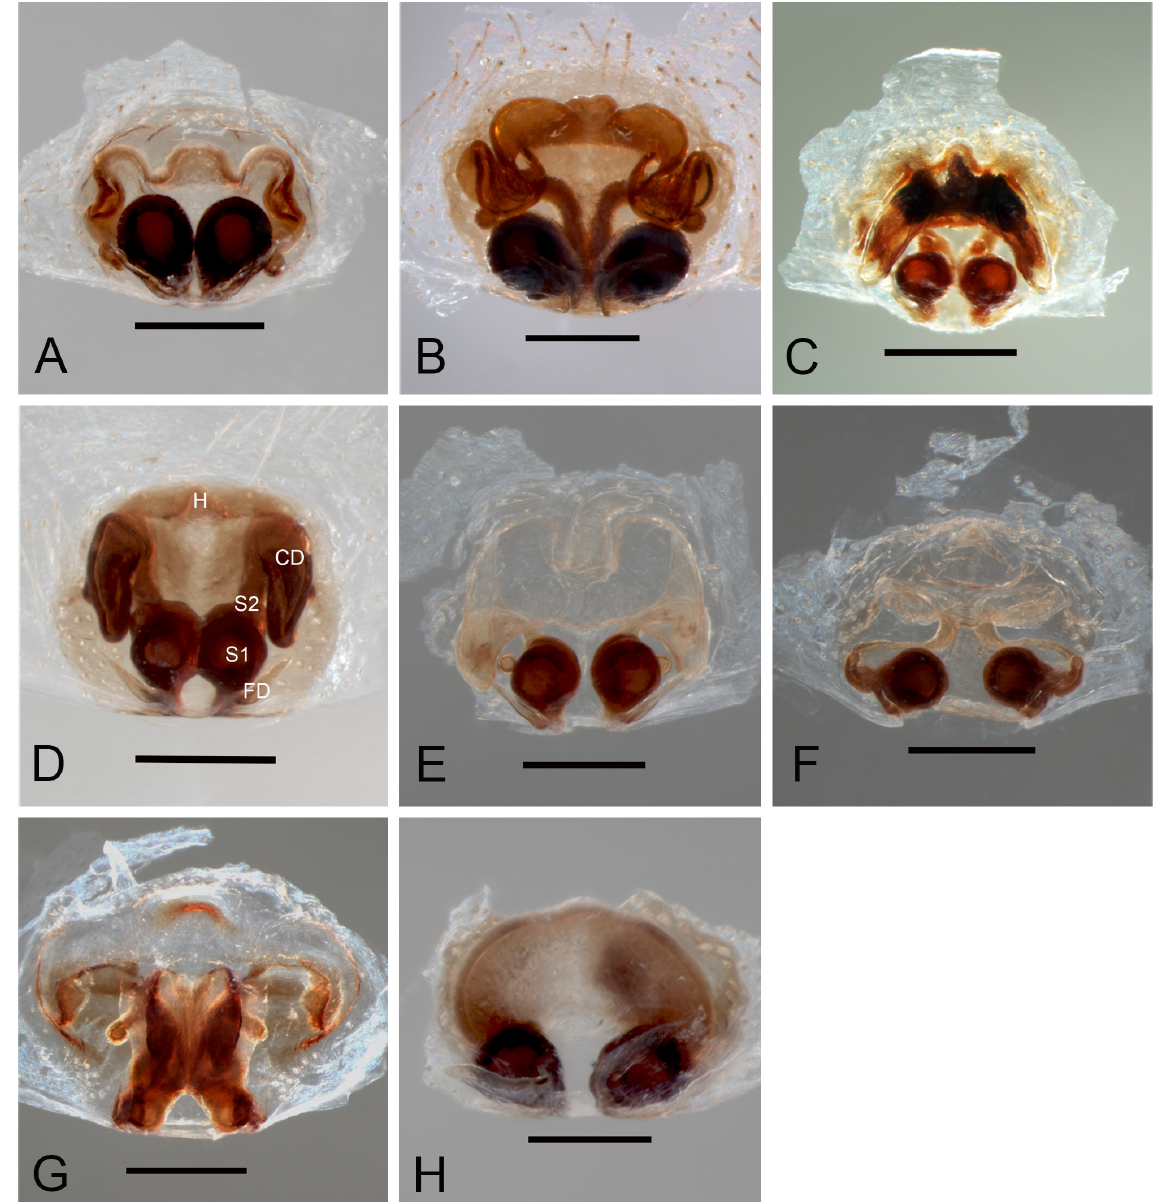
Fig. 33. Female genitalia, digested. A . Tafana huatanay sp. nov. (MUSM). B . Tafana ruizi sp. nov. (IBSP 258183). C . Tafana silhavyi (Caporiacco, 1955) (MNHN). D . Tafana maracay sp. nov. (MNHN 11314). E . Tafana arawak sp. nov. (MNHN 11320). F . Tafana pittieri sp. nov. (AMNH). G . Tafana oliviae sp. nov. (MCZ). H . Tafana orinoco sp. nov. (MIZA 07062). Abbreviations: CD = copulatory ducts; FD = fertilization ducts; H = hood; S1 = primary spermathecae; S2 = secondary spermathecae. Scale bars: A–H = 0.25